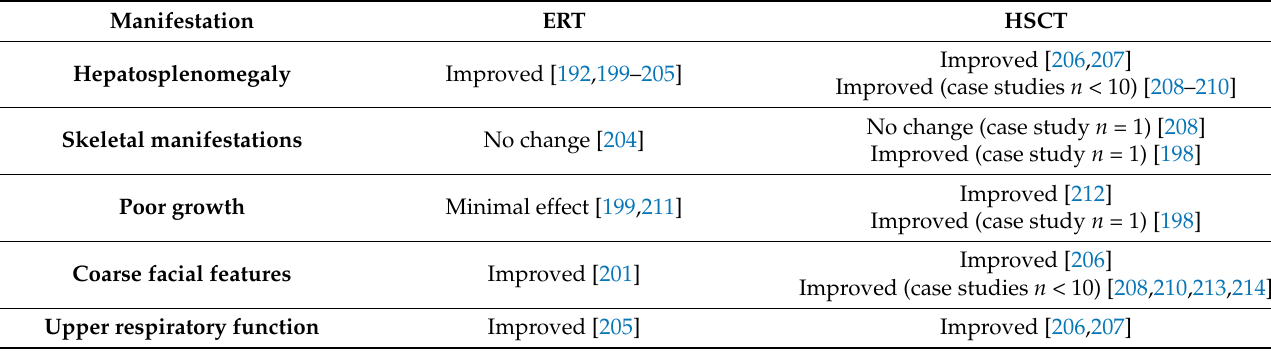
Table 4. Outcome of HSCT and ERT on manifestations in patients with MPS